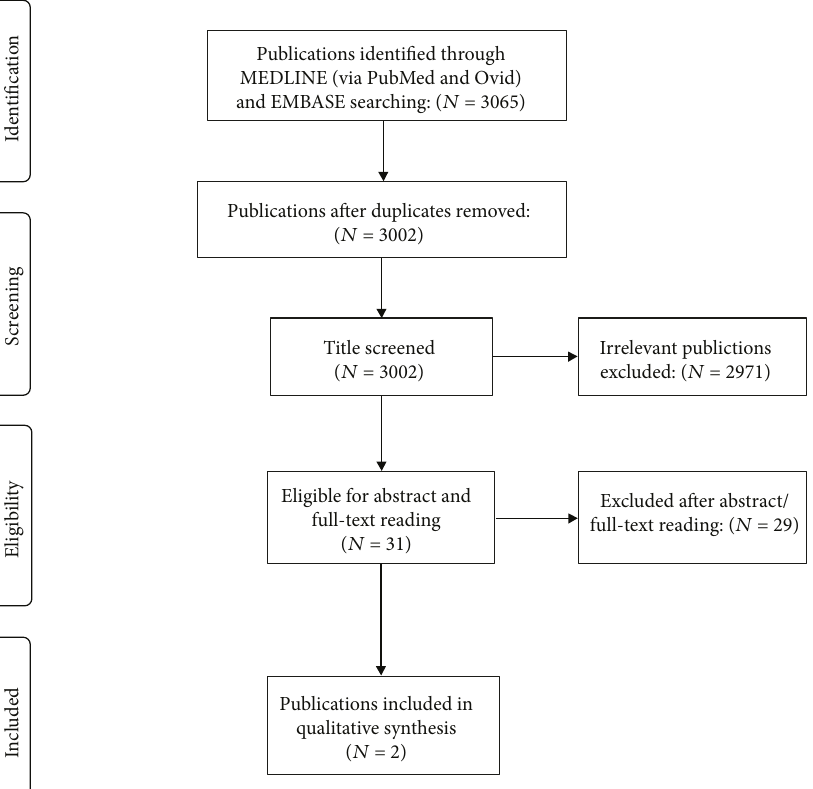
Figure 8: PRISMA diagram of systematic literature